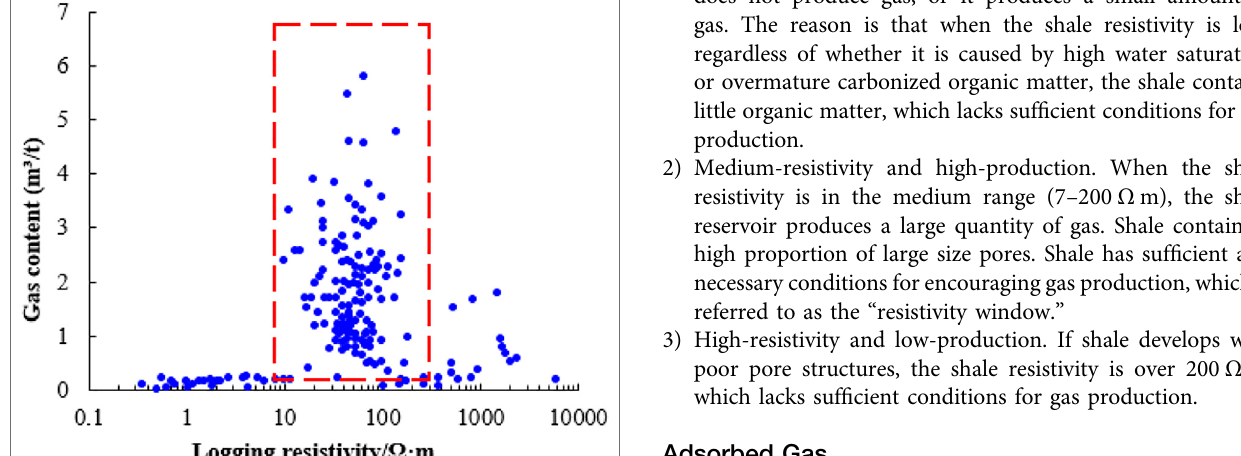
Frontiers in Earth Science |